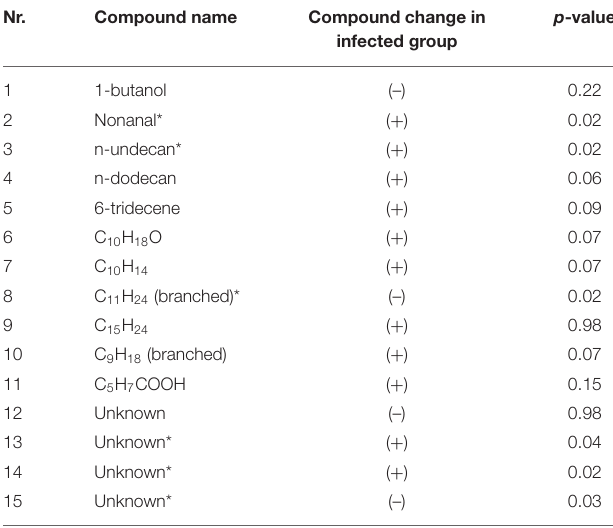
TABLE 1 | A list of 15 discriminatory VOCs, their putative identification, statistical significance (indicated as p-value obtained from rank test after correction for multitesting with Benjamin-Hochberg) and their relative concentration change in post-infection group with respect to pre-infection samples.